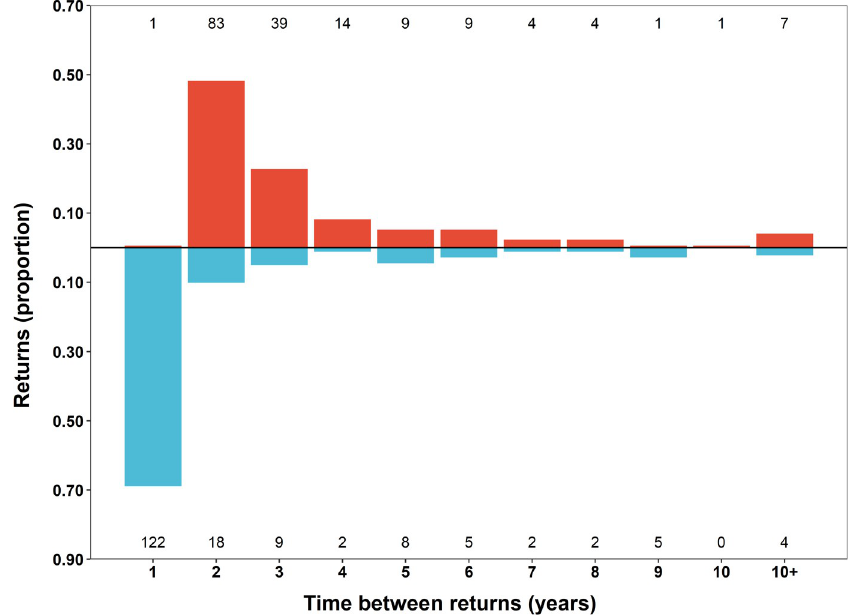
Fig 5. Annual return patterns of nurse sharks to the Dry Tortugas courtship and mating ground (DTCMG). The time between returns (in years) of nurse sharks returning to the DTCMG during the mating season (June-July). The proportion of total returns for females (red fill; N = 172 returns) and males (blue fill; N = 177 returns) are shown above and below the horizontal line at zero, respectively. Each year’s total number of individual returns is provided at the top and bottom of the panel for each sex, respectively. These returns reflect sharks tagged between 1993 and 2014, with return observations made through the mating season, 2021.